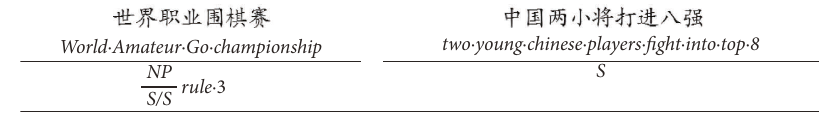
Figure 10: A CCG derivation with rule 3.